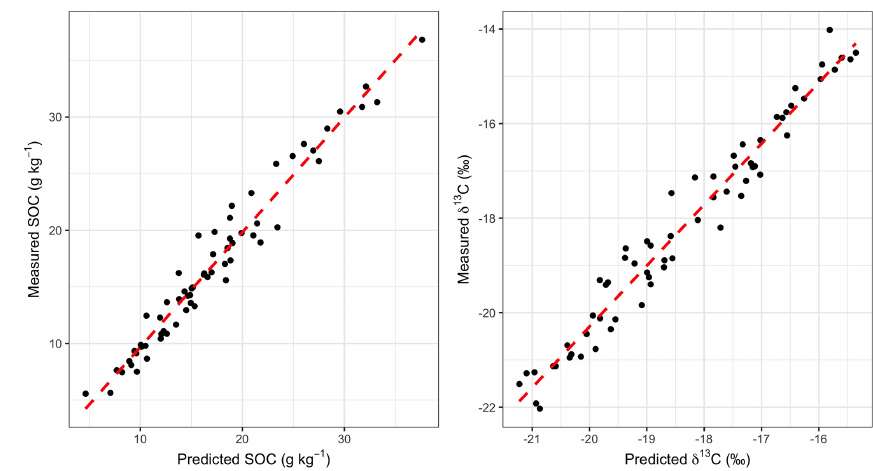
Figure 3. Predicted vs. measured SOC and δ 13 C based on MIR spectra for the Kayonza and Nyagatare LDSF sites,